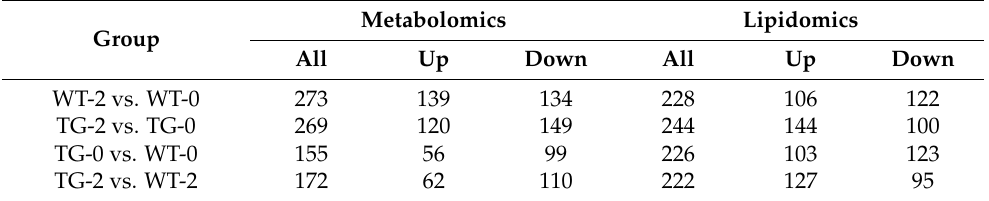
Table 2. The differential features detected with untargeted metabolome and lipidome between wild- type and PIGinH11 pigs at the baseline and after HFHSD feeding.